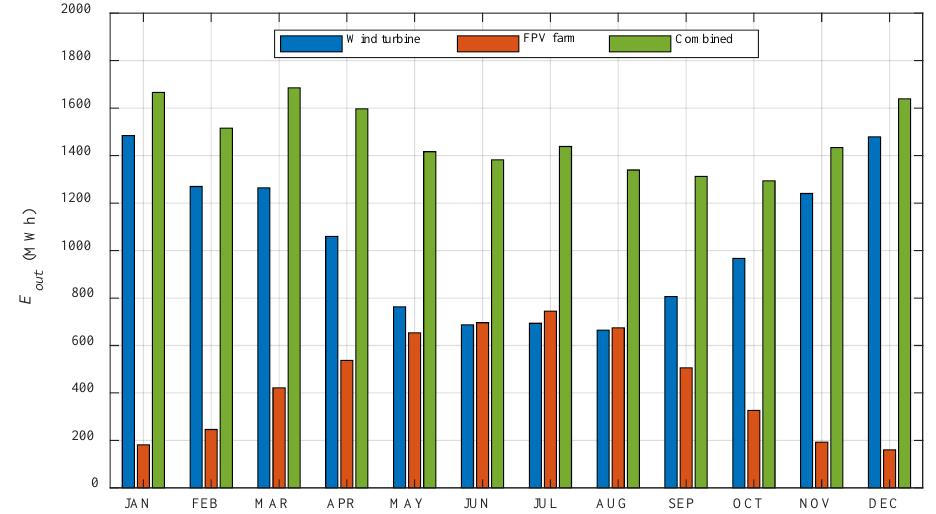
Figure 10. Monthly energy production at study site East of a 6.2 MW offshore wind turbine, a 5 MW FPV farm, and both combined.